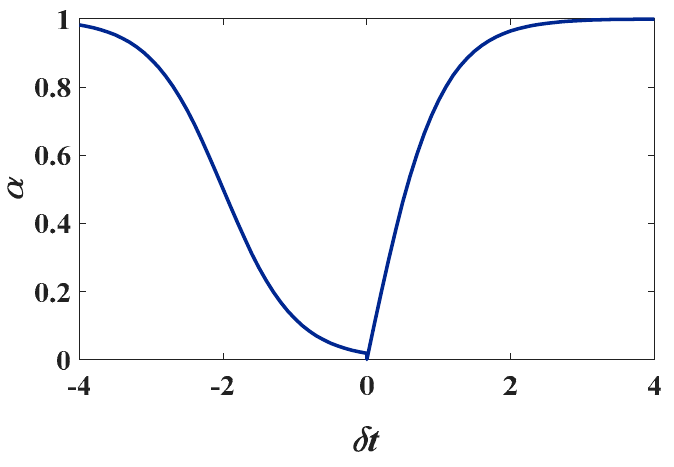
α δ curve. Figure 8. The α − δ t curve. - t Figure 9a,b shows the RDM before and after removing the vibration. Our algorithm can retain the gesture region well and filter out the micro-vibration objects and local anomaly regions for subsequent processing.